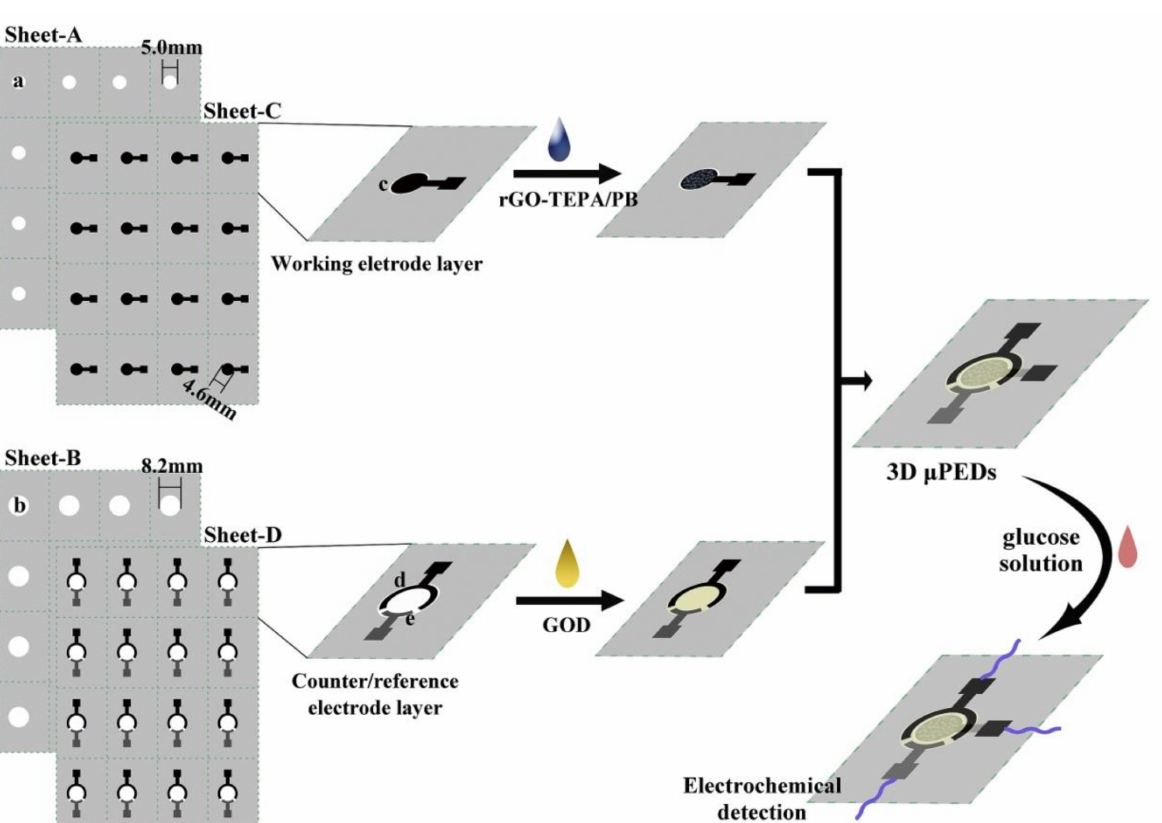
Figure 23. Preparation of a three-dimensional microfluidic electrochemical biosensor based on paper. ( a ) preparation of a three-dimensional microfluidic electrochemical biosensor based on paper, ( b ) 8.2 mm hydrophilic zone, ( c , d ) carbon as counter and working electrode, and ( e ) reference electrode Ag/AgCl). (Reproduced from [472] with permission. Copyright 2019, Elsevier, Amsterdam, The